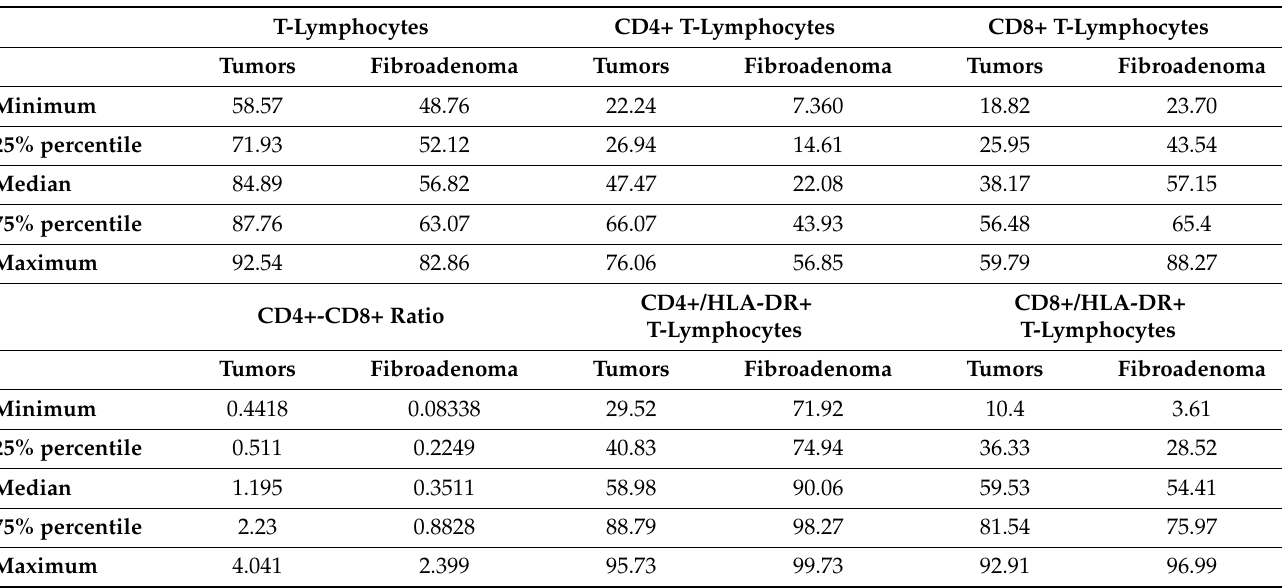
Table 2. Statistical values of the T-lymphocytes subsets. Values are reported as the median percentage of gated